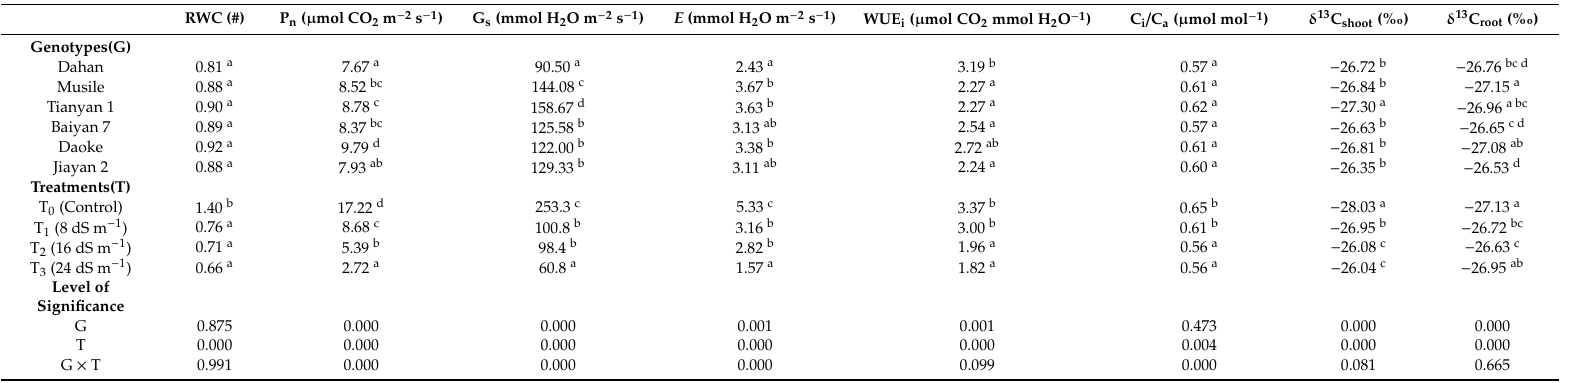
Table 3. E ff ect of various levels of salinity on the relative water content (RWC), leaf net photosynthetic rate (P n ), stomatal conductance (g s ), transpiration rate ( E ), intrinsic water use e ffi ciency (P n / E, WUE i ), the ratio of intercellular to ambient CO 2 concentration (C i / C a ) and the stable carbon isotope composition (% (cid:24) ) of shoots ( δ 13 C shoot ) and roots ( δ 13 C root ) of six oat genotypes. Genotype values are the means of 12 measurements, while treatment values are the means of the 18 measurements. Means followed by di ff erent letters are significantly di ff erent ( p < 0.05) according to Tukey’s-b